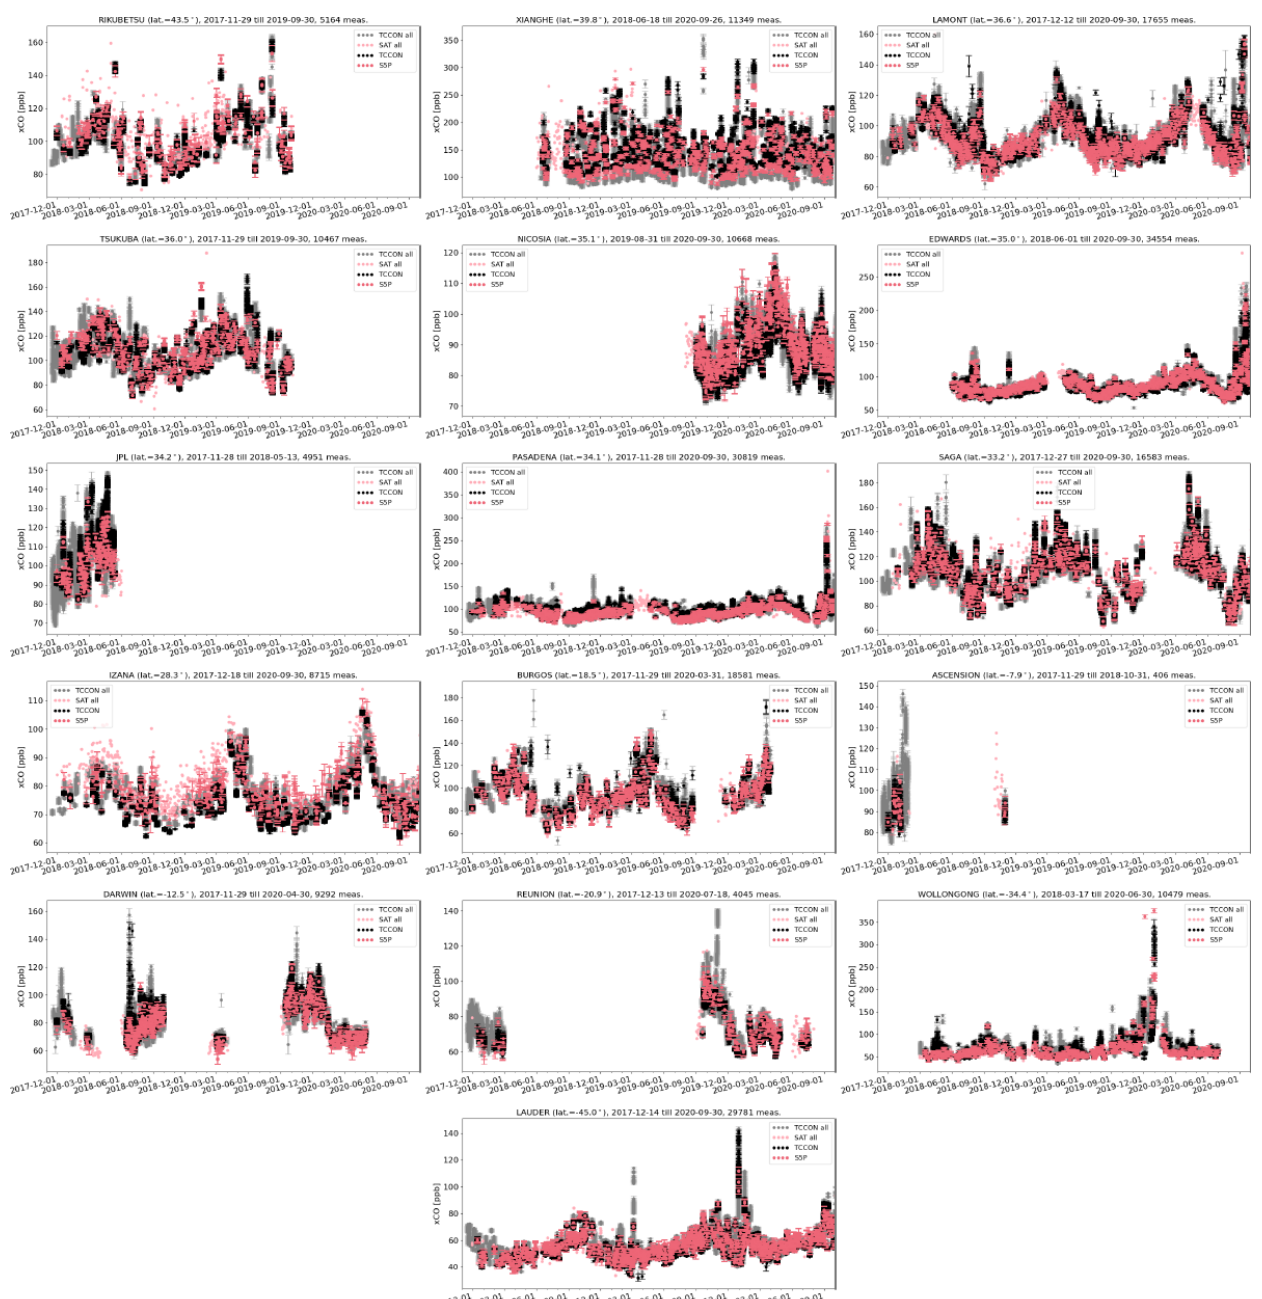
Figure 20. Same as Fig.